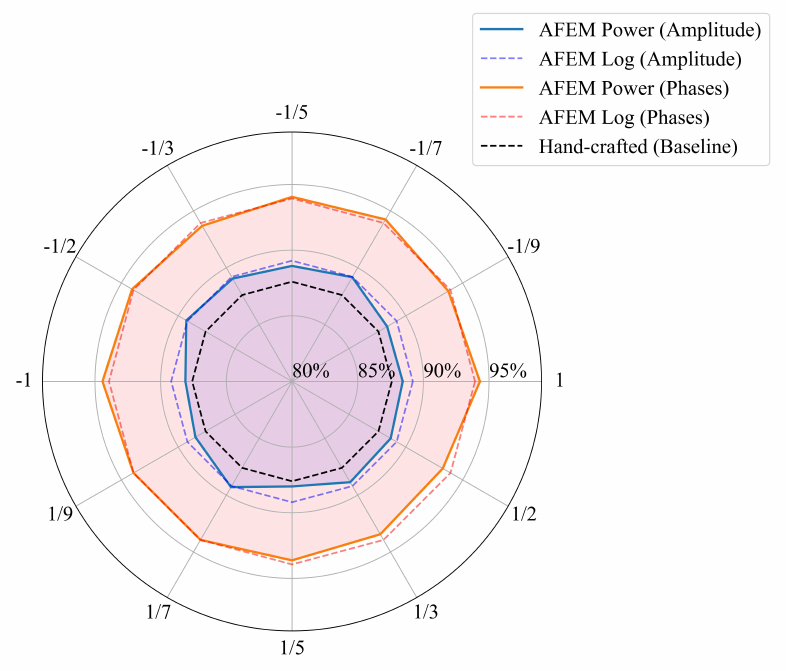
Figure 12. Different γ values affect AFEM (validation set). Note : Here is an example of the legend (AFEM Log (Amplitude)): The amplitude features are used in AFEM, and the activation function is the